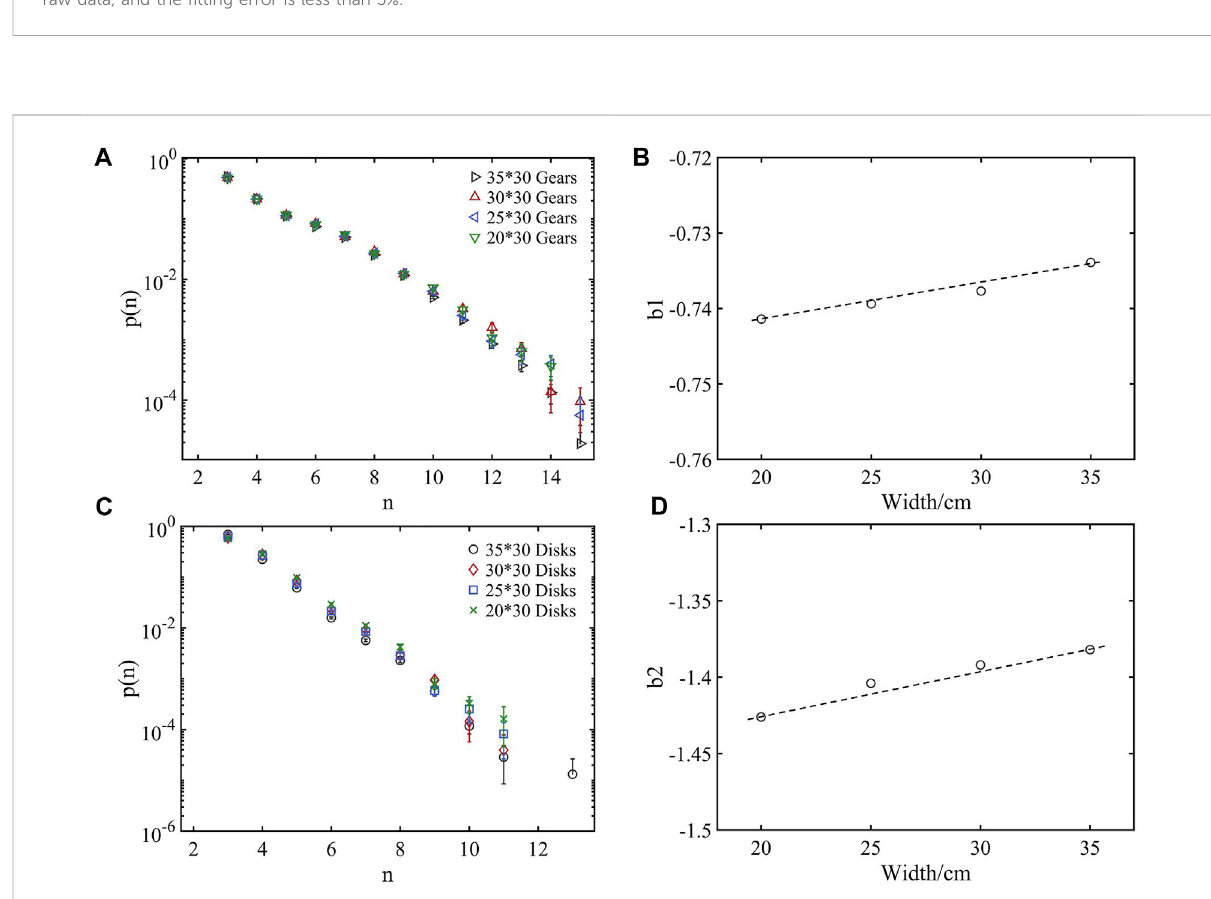
FIGURE 4 The cell order probability distribution of gear particles and disk particles with different container width; (A) Cell order distribution of gear particles; (B) Changes of the fi tting parameter b1 for gear particles; (C) Cell order distribution of disk particles; (D) Changes of the fi tting parameter b2 for disk